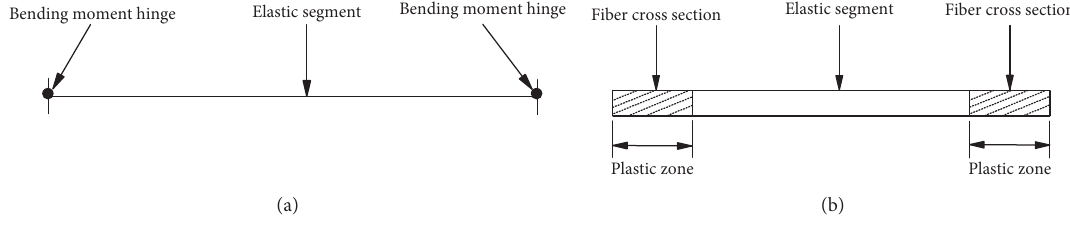
Figure 1: (a) Plastic hinge model. (b) Fibre model.